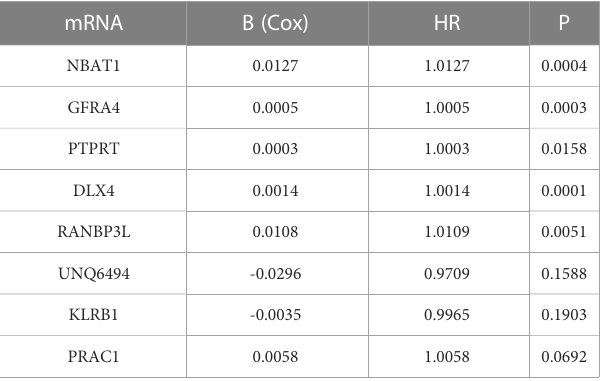
TABLE 2 Details of 8 prognostic mRNAs signi fi cantly related to survival in patients with endometrial cancer. mRNA B (Cox) HR